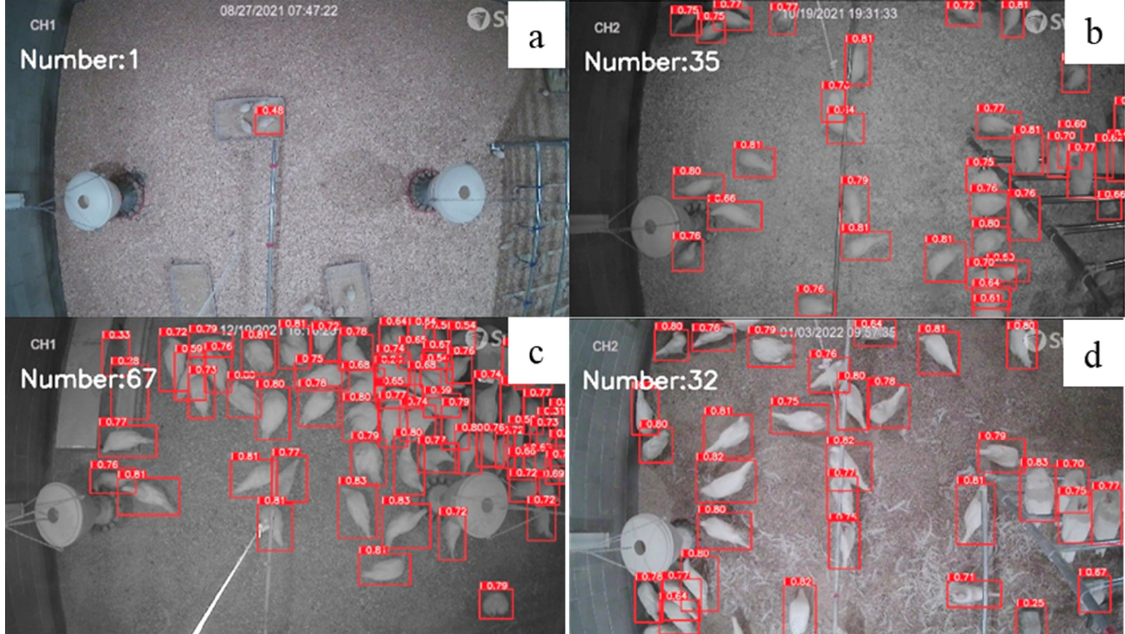
Figure 10. Number of chickens identified under different ages: ( a ) 1 week old, ( b ) 8 weeks old, ( c ) 16 weeks old, and ( d ) 18 weeks old with the newly developed model.